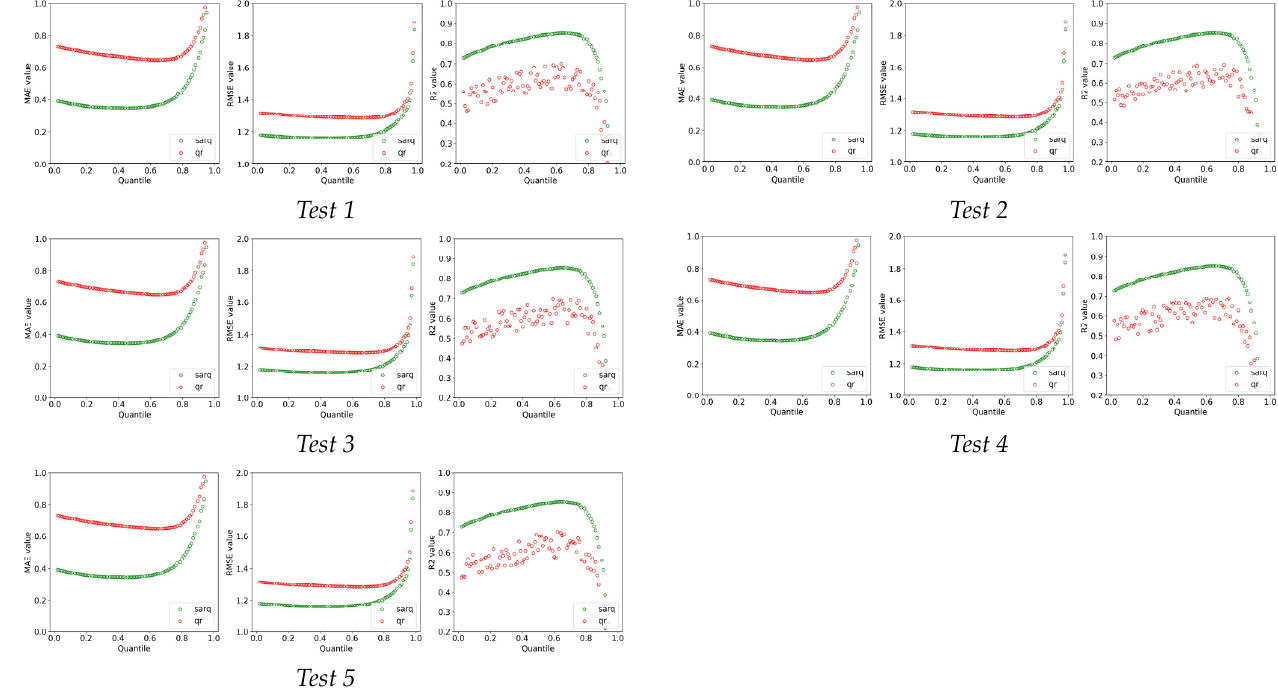
Figure A2. Model performance of fatal-plus-injury crash rate